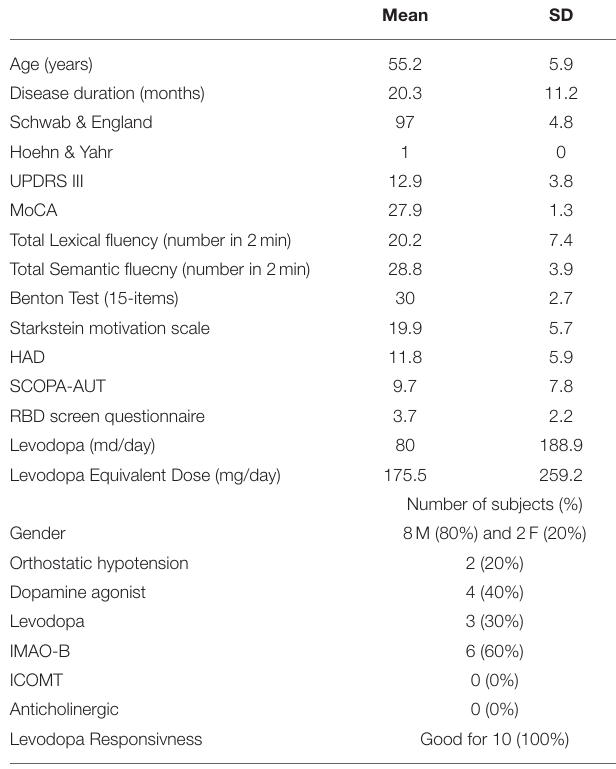
TABLE 1 | Patients’